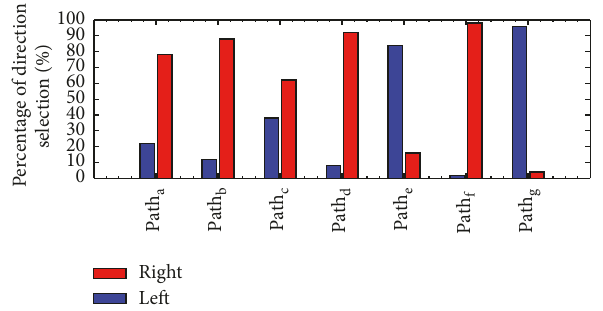
Figure 4: Percentage of direction selection in different relative positions between